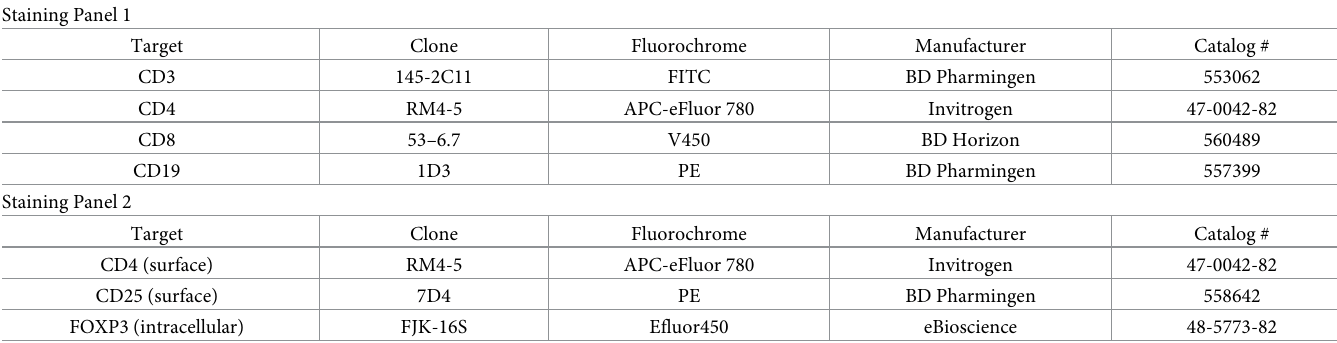
Table 1. Antibodies used for spleen